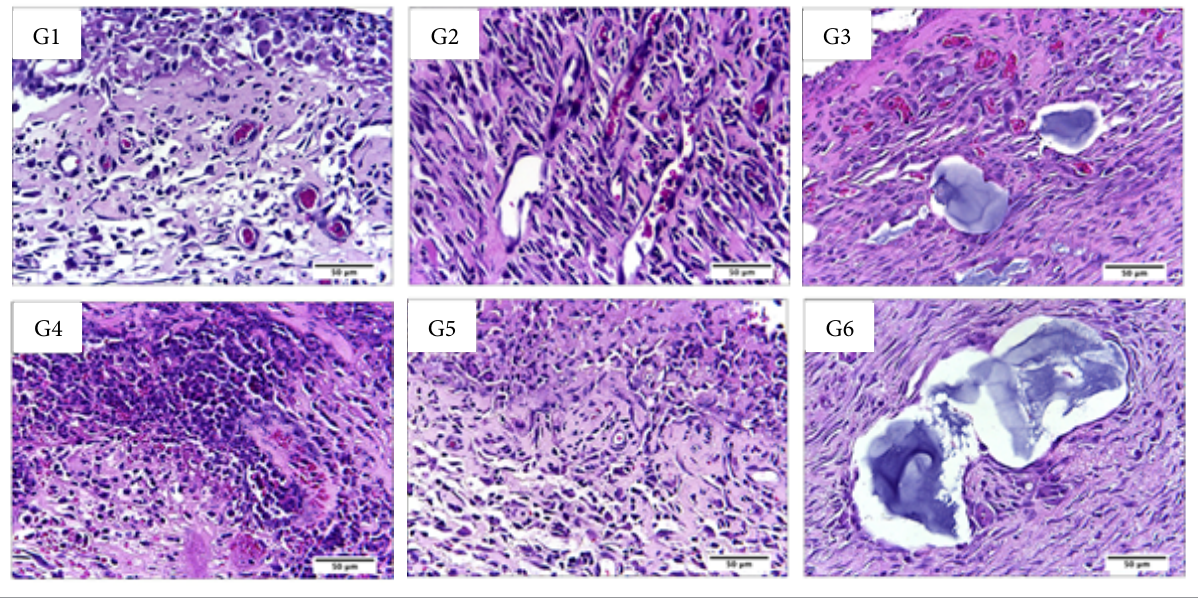
Figure 7 - Microscopic aspects of partial thickness burn wounds experimentally induced in Wistar rats 14 days after the injury induction. Stain hematoxylin and eosin. Augmentation: 40x scale in μ